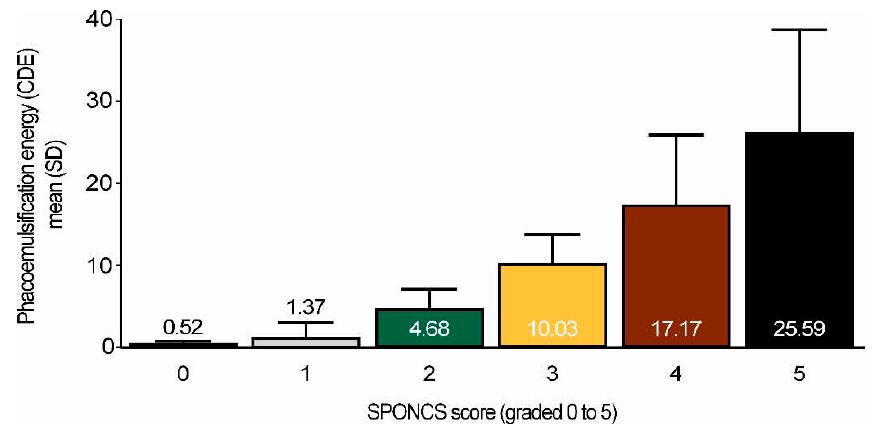
Figure 6. Phacoemulsification energy (CDE) levels according to the different Standard Pre-Operative Nuclear Classification System (SPONCS) scores. Mean CDE levels are presented in the bars. Spearman ′ s rho = 0.8, p < 0.001.